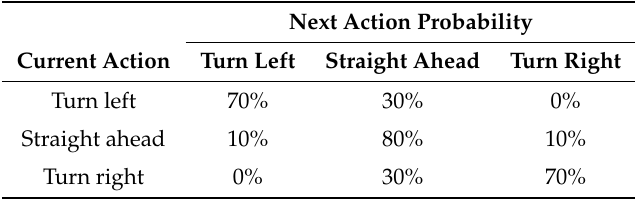
Table 2. UAV action